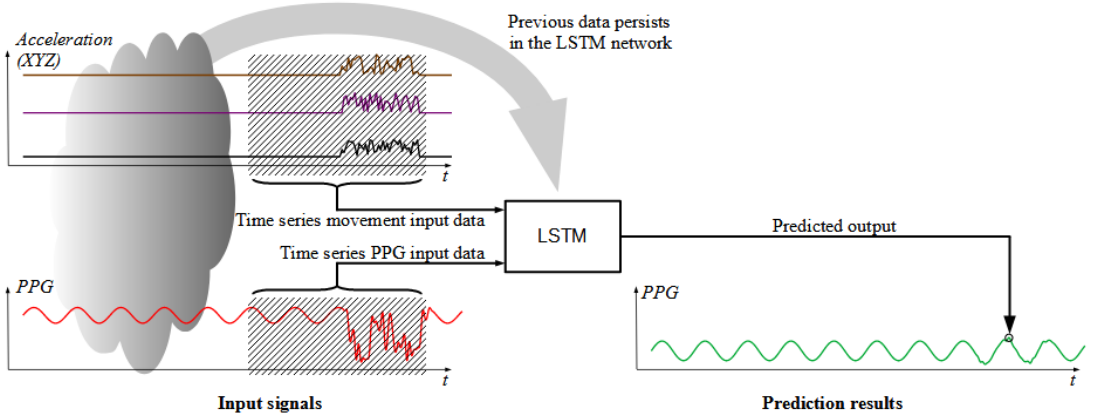
Figure 1. Idea of PPG signal correction with accelerometer signals and time series LSTM network.